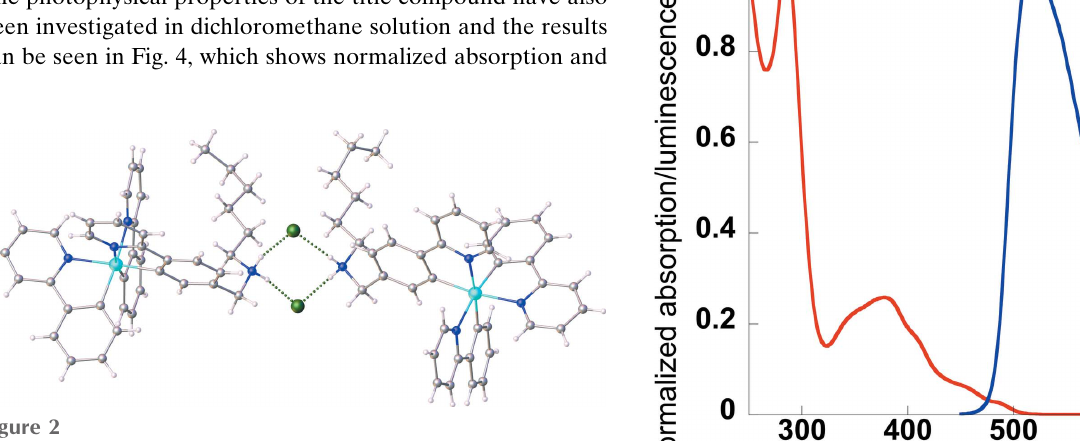
Figure 4 The photophysical properties of the title compound.